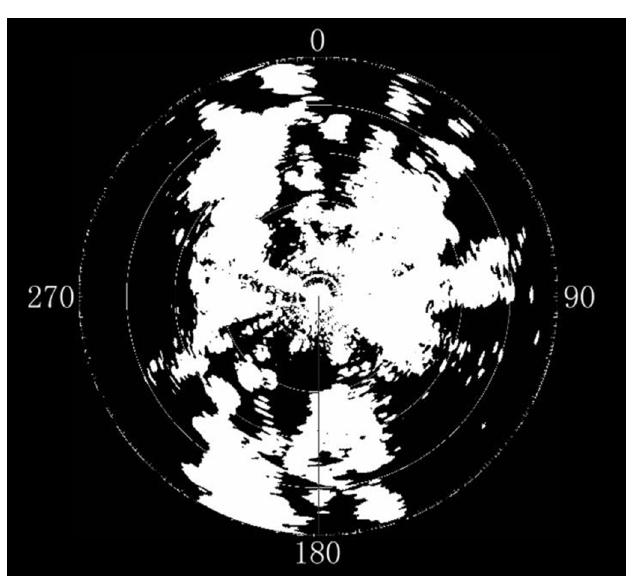
Fig. 3. Echo signal diagram before